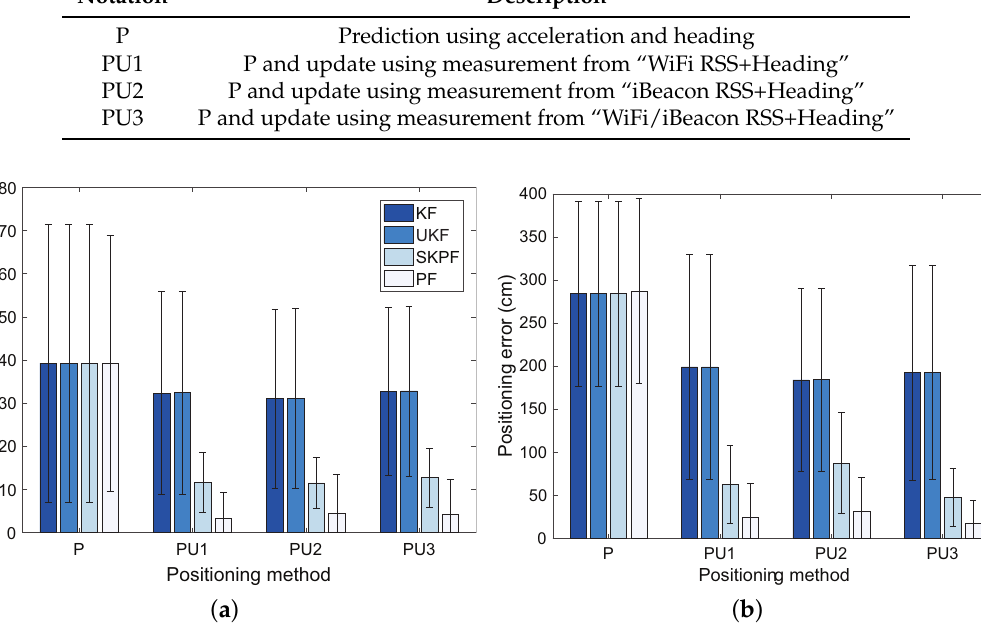
Figure 12. Performance of the localization algorithms for Scenarios ( a ) S1 and ( b ) S2 in terms of average and standard deviation of the positioning